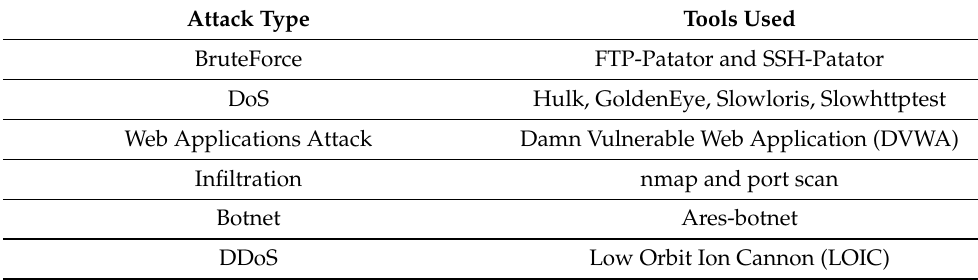
Table 2. Tools used in each